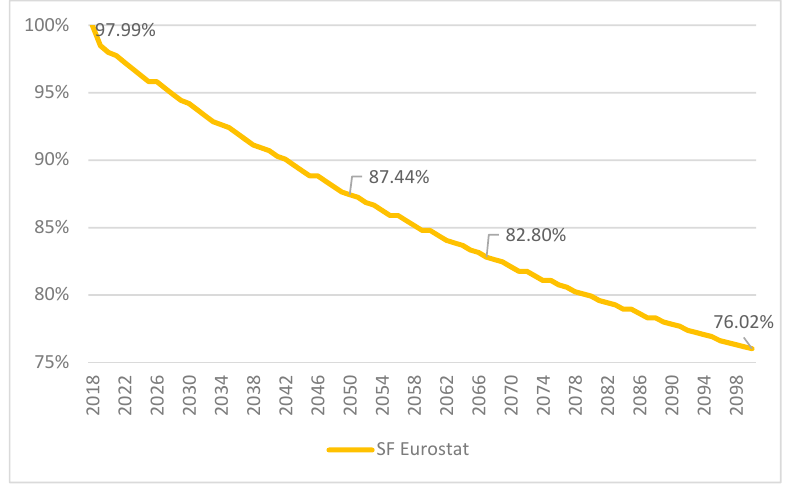
Figure 3. Sustainability factor 2018–2100, Eurostat tables. Source: Prepared by the authors.